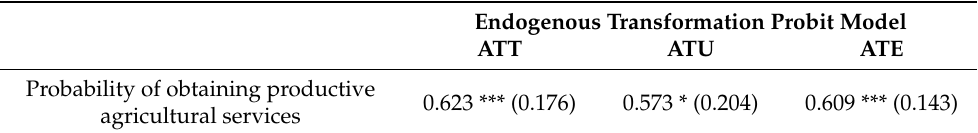
Table 2. Processing effect of migrant workers on the probability of farmers obtaining productive agricultural